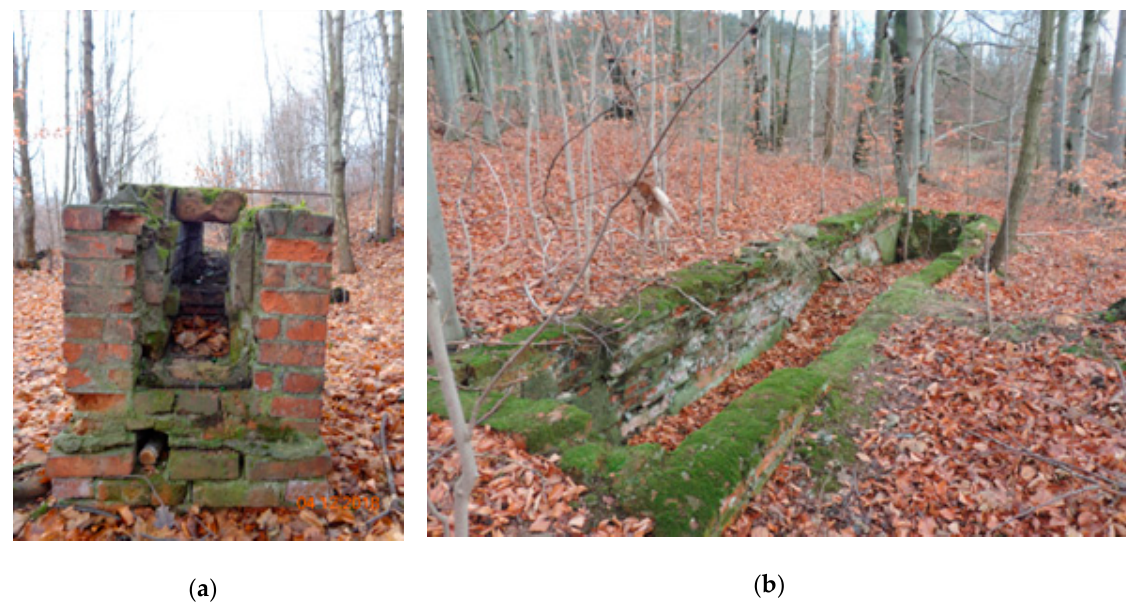
Figure 16. The remains of the barracks of the Krupp LZA Wüstegiersdorf: ( a ) remains of the chimney; please, note the two-sided access to the furnace, photo P. Lewandowski; ( b ) the remains of the presumed pantry, photo P. Bylina.